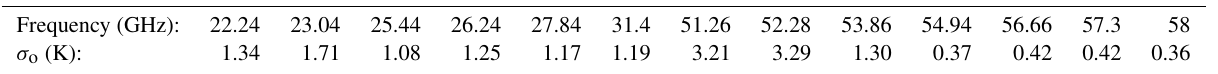
Table 1. Observation uncertainties (K) corresponding to MWR brightness temperature measurements prescribed in the observation error covariance matrix for each channel. Frequency (GHz): 22.24 σ o (K): 1.34